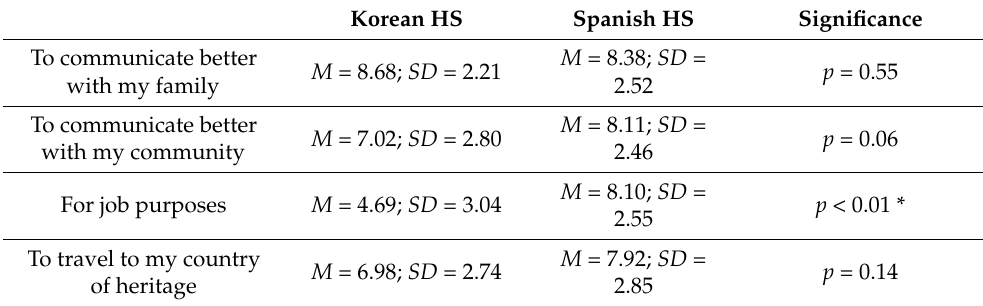
Table 4. HL purposes across HS